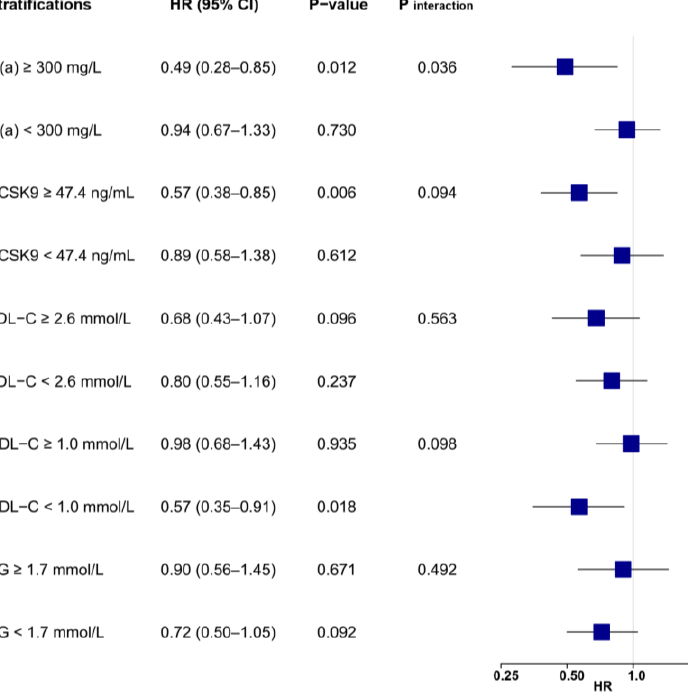
Figure 5. Associations between LL-37 and the risk of secondary composite endpoint (cardiac death, recurrent MI, and ischemic stroke) according to lipid profile values. Multivariable Cox regression was adjusted for variables with p < 0.1 in univariable analysis (see Supplementary Table S2), including age, body mass index, hypertension, previous MI, heart rate, ejection fraction, hemoglobin, creatinine, glucose, hemoglobin A1c, high-sensitivity C-reactive protein, cardiac troponin I, N-terminal prohormone of brain natriuretic peptide, LDL-C, multivessel diseases, successful revascularization, and P2Y12 inhibitor. HDL-C = high-density lipoprotein cholesterol; LDL-C = low-density lipoprotein cholesterol; lp(a) = lipoprotein(a); MI = myocardial infarction; PCSK9 = proprotein convertase subtilisin/kexin type 9; TG = triglyceride.